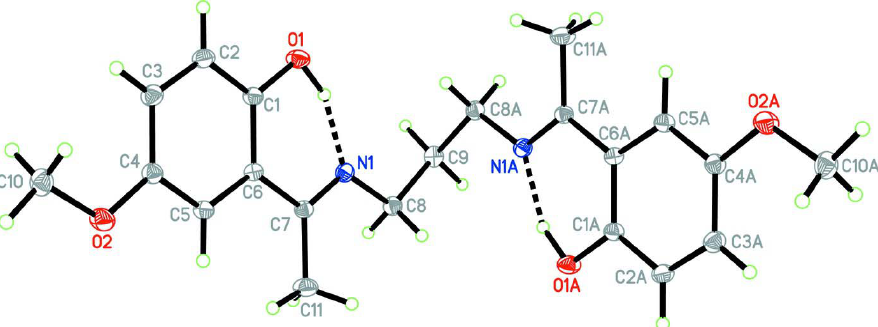
Figure 1 The molecular structure of (I) with atom labels and 50% probability ellipsoids for non-H atoms. The suffix A corresponds to symmetry code (- x + 1, y , - z + 1/2).